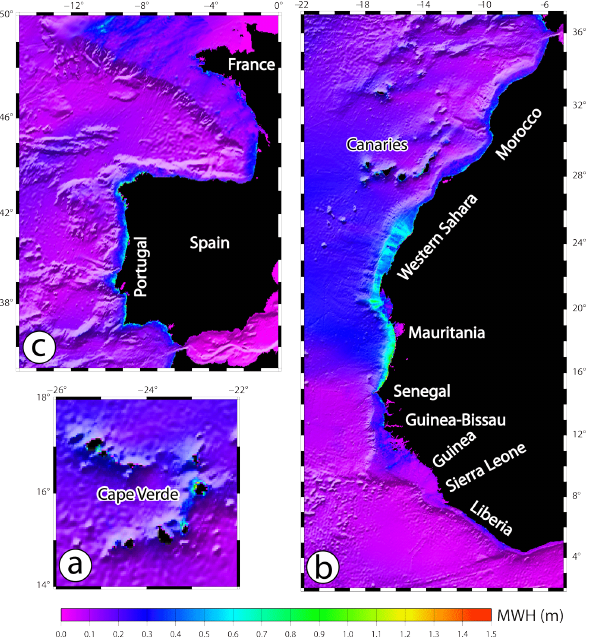
Figure 5. Maximum wave height maps after 12h of tsunami propa- gation across the Atlantic Ocean for the 1843-like scenario (no. 2). It highlights coastal amplifications along the French and Portuguese margins (a) , in the Cape Verde archipelago (b) and along the west- ern African margin linked mainly to submarine canyon locations.